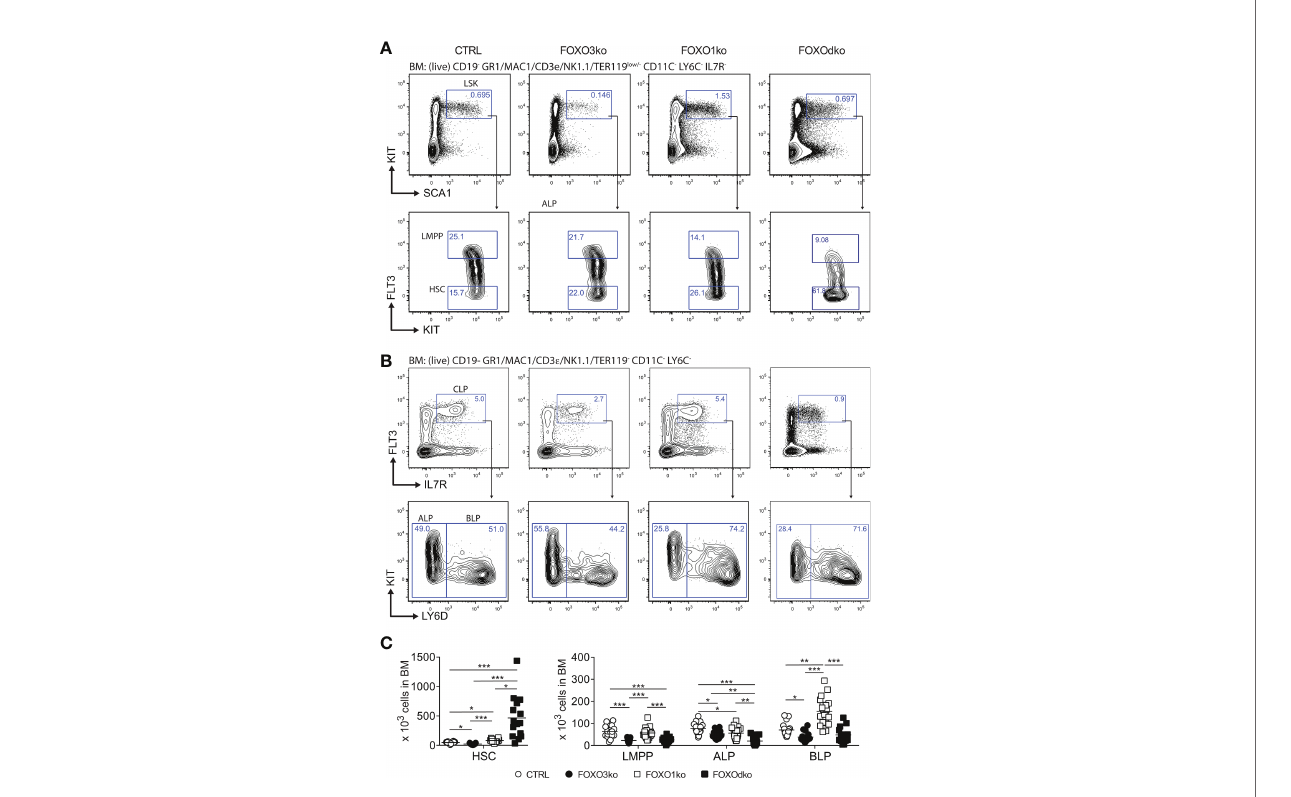
FIGURE 2 | Development of lymphoid progenitors is perturbed by the loss of FOXO1 and FOXO3. (A, B) Gating strategy for identi fi cation of stem and lymphoid progenitor cells. For complete gating see Fig. S3A. (C) Total number of progenitor cells in BM. In panel (C) each dot represents data from an individual mouse; p-values were calculated using the Kruskal Wallis test with Dunn ’ s test of multiple comparisons; *, ** and *** indicating p-values <0.05, <0.01, and <0.001